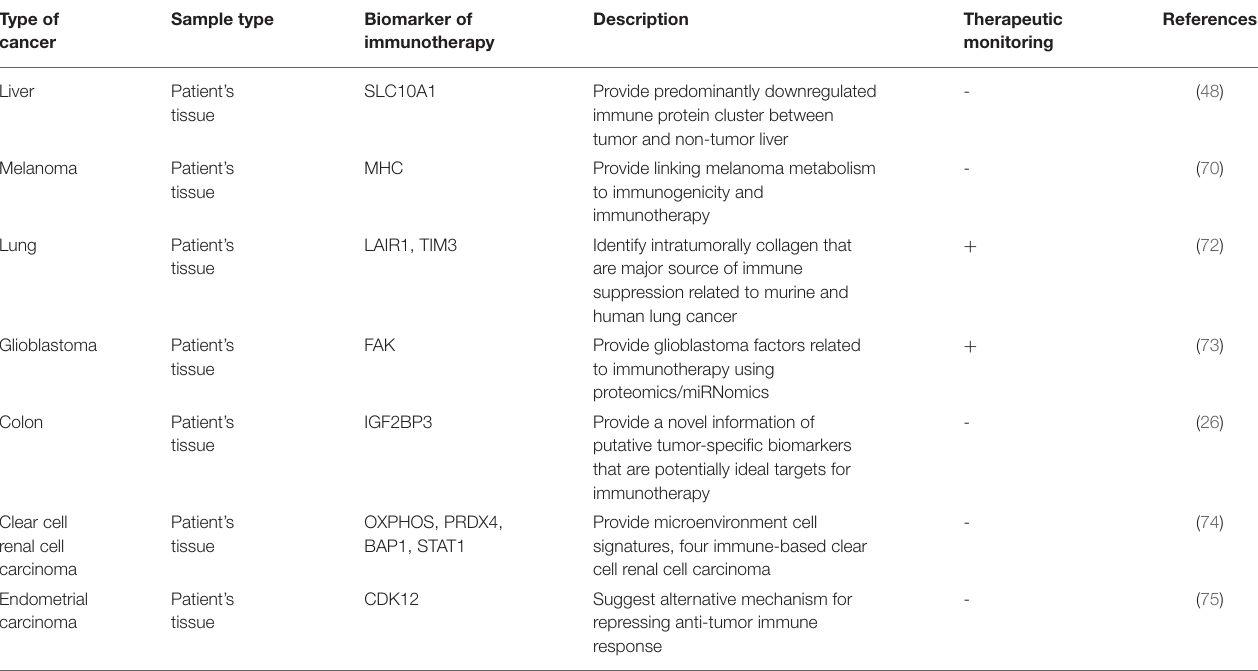
TABLE 3 | List of biomarkers discovered by proteomics approaches to